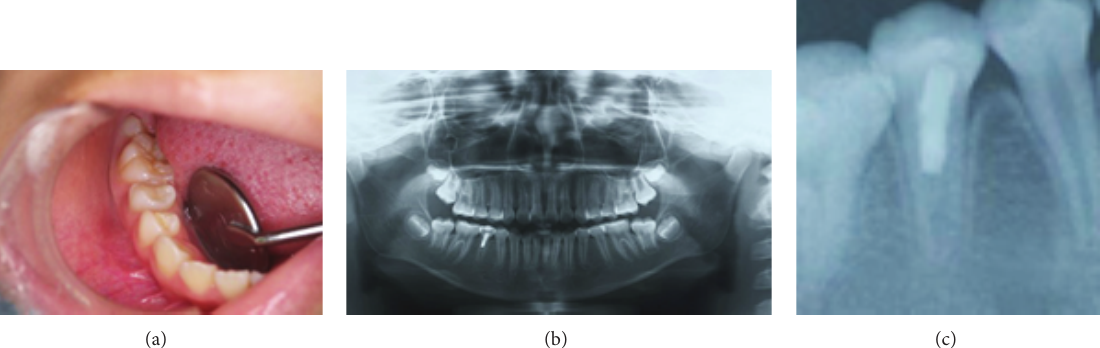
Figure 4: (a) Intraoral photograph showing no abnormalities of gingiva. (b) Panoramic X-ray showing the formation of a dentin bridge and thickening of the canal walls in the mandibular right second premolar. (c) Panoramic X-ray showing the formation of a dentin bridge and thickening of the canal walls and establishment of the periodontal ligament space and lamina dura in the mandibular right second